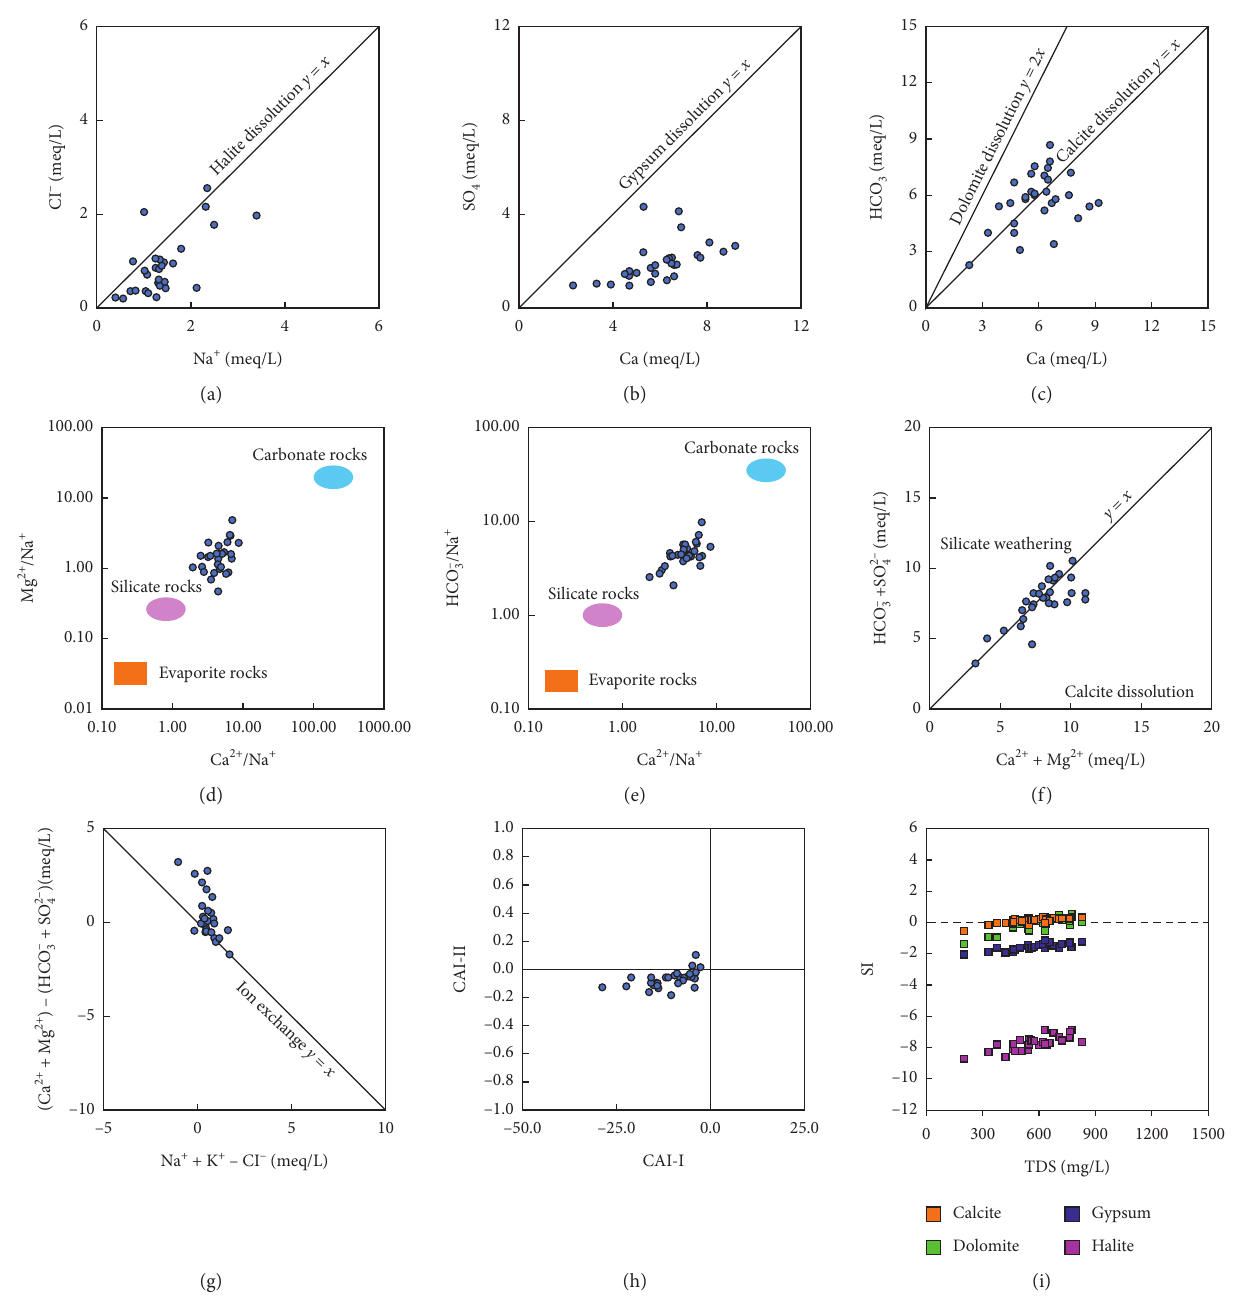
Figure 6: Correlation diagrams of (a) Cl − vs. Na + , (b) SO 42 − vs. Ca 2+ , (c) HCO vs. (Ca 2+ /Na + ), (f) HCO 3 − +SO 42 − vs. Ca 2+ +Mg 2+ , (g) (Ca 2+ +Mg 2+ ) − (HCO 3 − +SO 42 − ) vs . Na + +K + − Cl − , (h) chloroalkaline indices CAI- I vs. CAI-II, and (i) SI vs .